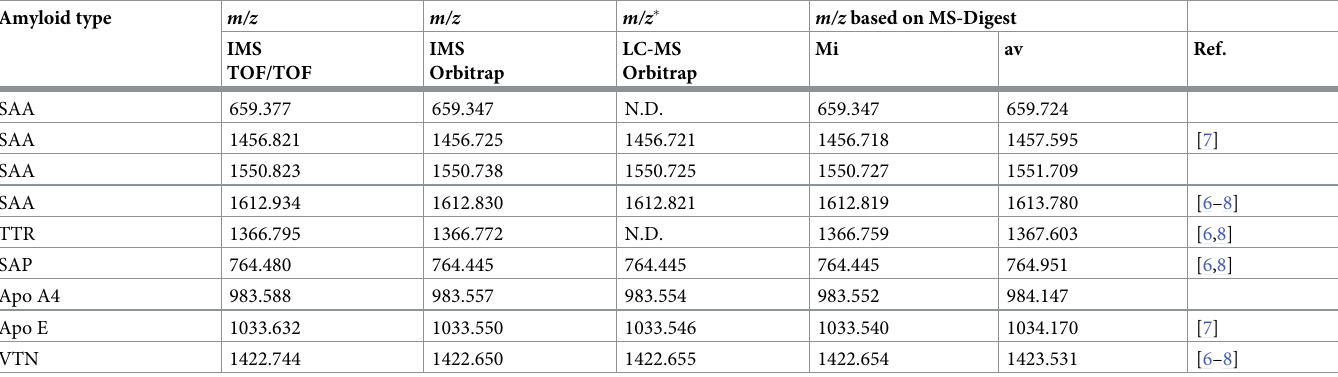
Table 1. Identification of peptides in cardiac tissues of patients with AA and ATTR